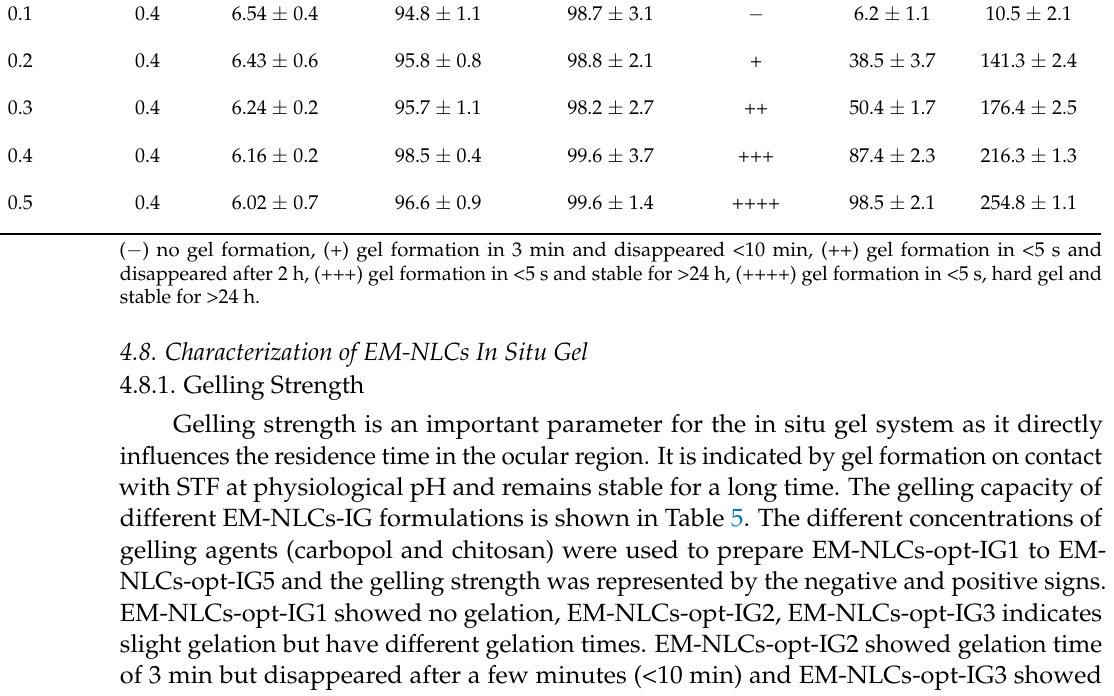
Table 5. Physicochemical parameter evaluation of EM-NLCs in situ gel system. The study per- formed in triplicate and data shown as mean ± SD.